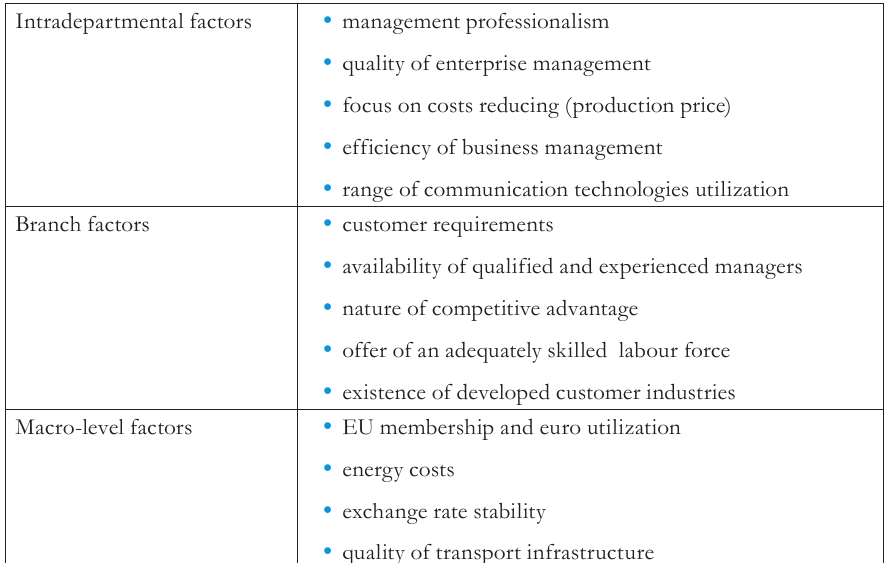
Tab. 4 – The most important factors of Slovak enterprises competitiveness. Source: own re-